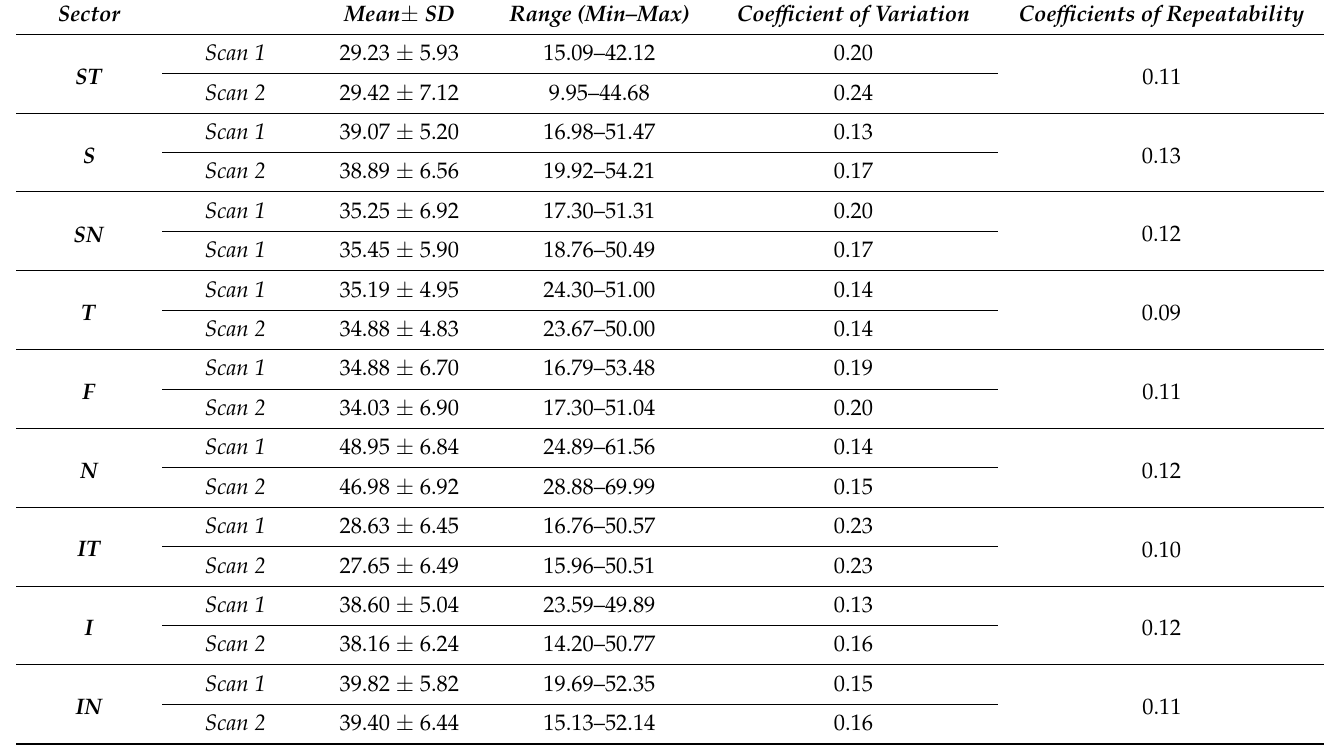
Table 3. SCP vessel density analysis.